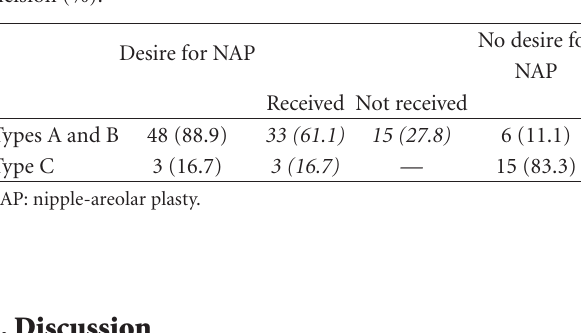
Table 4: Relations between nipple-areolar complex and type of incision